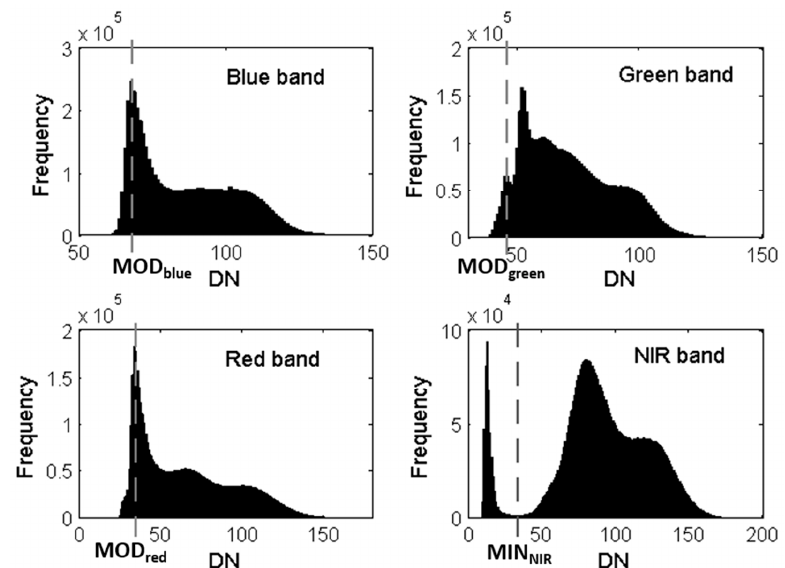
Figure 10. Histogram thresholding of blue, green, red, and near-infrared (NIR) bands (e.g., image ETM+ of 8 June 2001) for clear deep-water dark targets